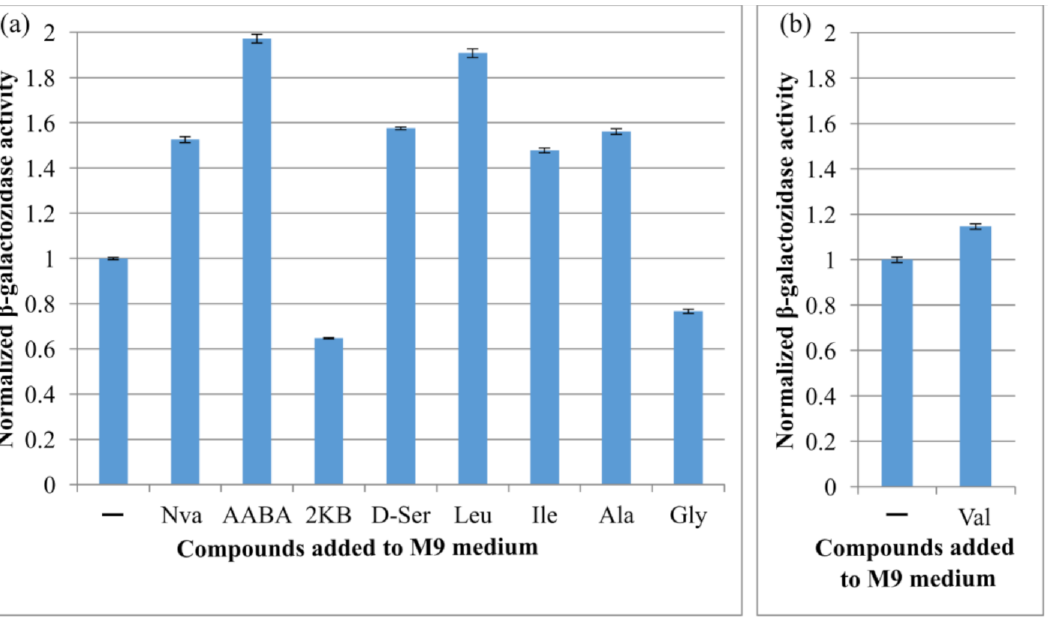
Figure 4. Influence of different amino acids on the expression level of lacZ gene under P cycA regulatory region. Strain ( a ) M2 or ( b ) M3, possessing the cat -P cycA - lacZ translational fusion, was incubated in parallel in minimal medium (M9) with or without addition of 10 mM of the indicated compound at 37 ◦ C for 5 h, and the β -galactosidase activity was measured. The values were normalized to the activity level in M9. The data are the mean values of three replicates with standard